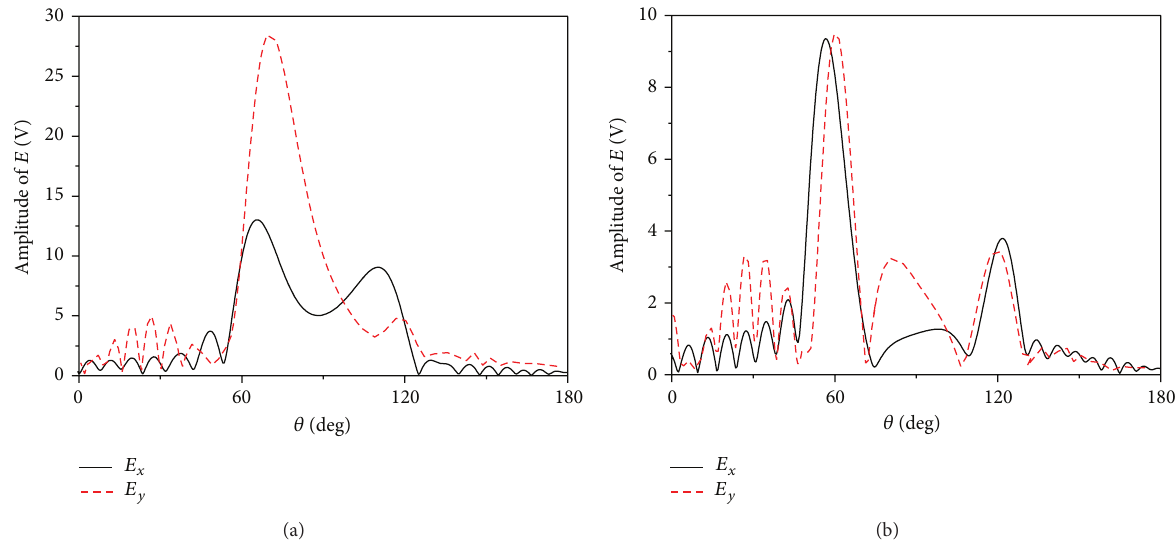
Figure 4: Amplitudes of the two electrical field components radiated by the SIW leaky-wave antenna for different lengths of N-shaped slots, 𝑓 = 8 GHz, 𝐿 = 5 mm, (a) 𝑊 = 6 mm, and (b) 𝑊 = 4.2 mm.